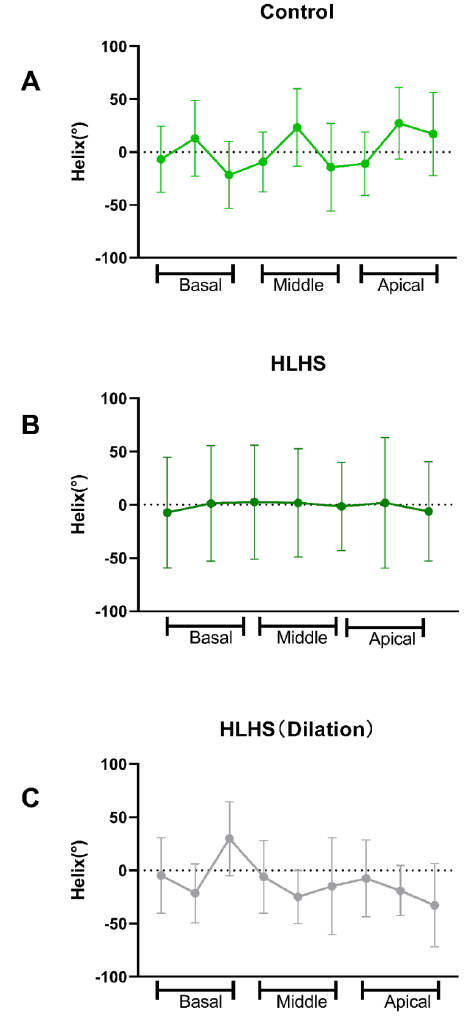
Figure 5. ( A ) HA gradient in normal fetus. ( B ) HA gradient in HLHS fetus. ( C ) HA gradient in an HLHS fetus with LV dilation.